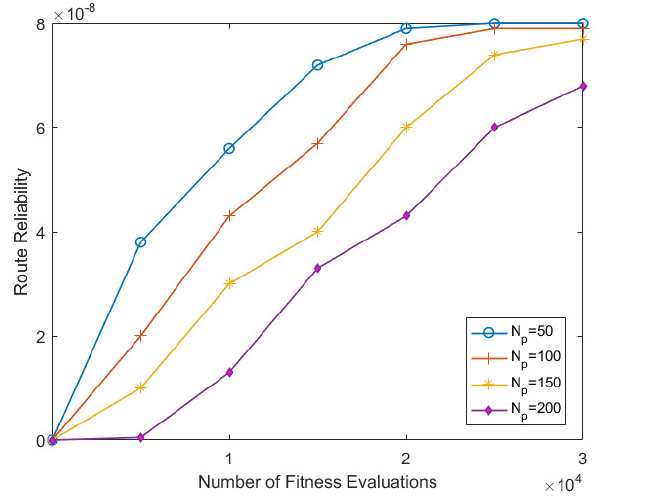
Figure 5. Mean route reliability results achieved over 1000 Monte Carlo trails based on varying population size ( N P ) .